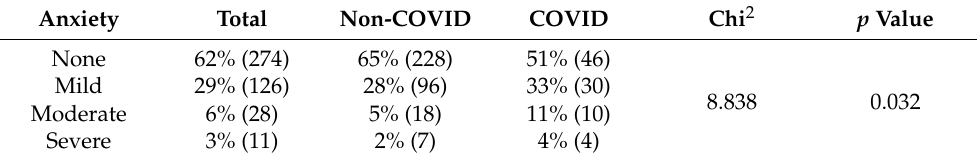
Table 5. GAD-7 score distribution.